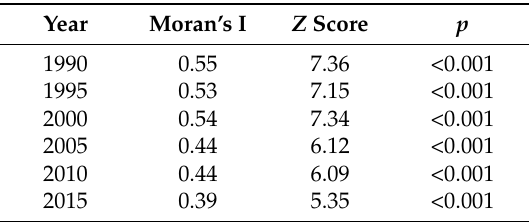
Table 2. Global spatial autocorrelation of stroke mortality PM 2.5 in 1990–2015,